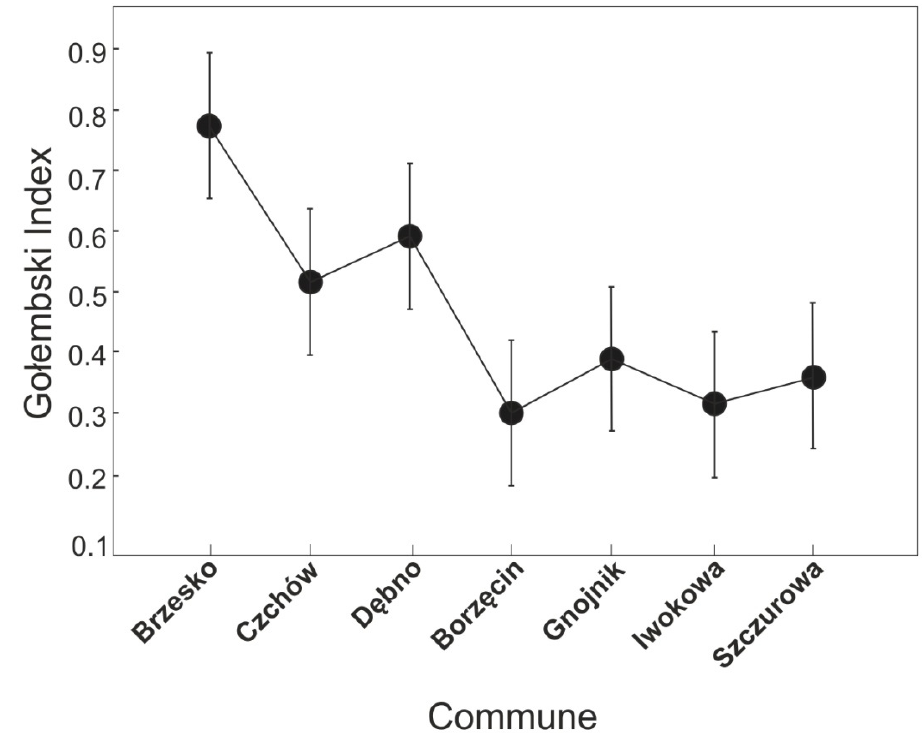
Figure 6. Mean values ± SD of Gołembski index for studied communes.